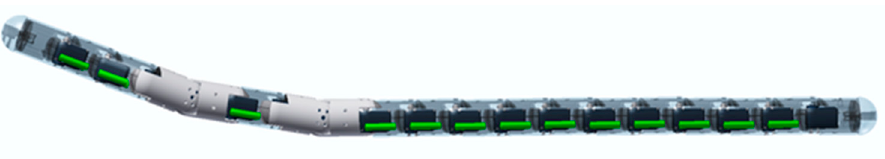
Figure 8. Position of the rotated assembly in NEELBOT 1.2.